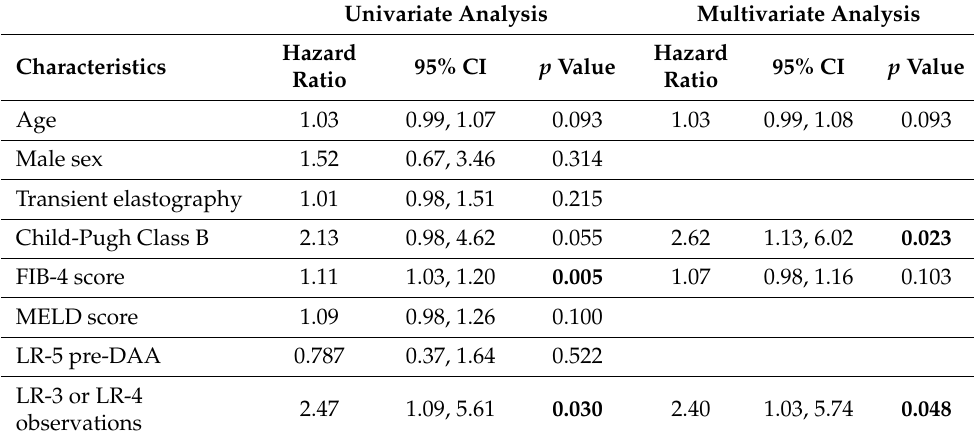
Table 3. Univariate and multivariate cox proportional hazards model for LR-5 occurrence after direct acting antivirals. Univariate